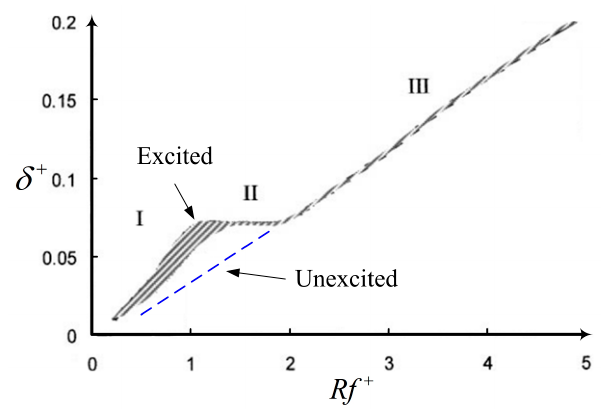
Figure 8. Momentum Thickness Development of Excited Turbulent Free Shear Flows (Referring to [1]).